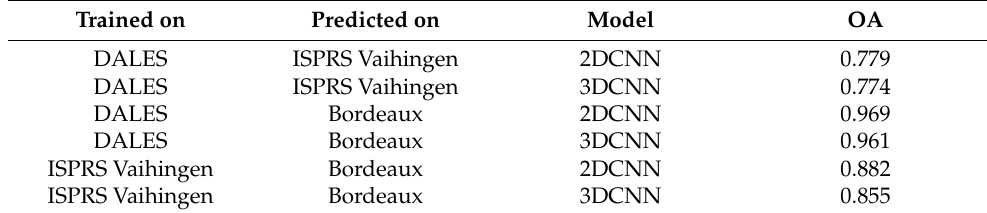
Table 22. Summarized OA for the generalization